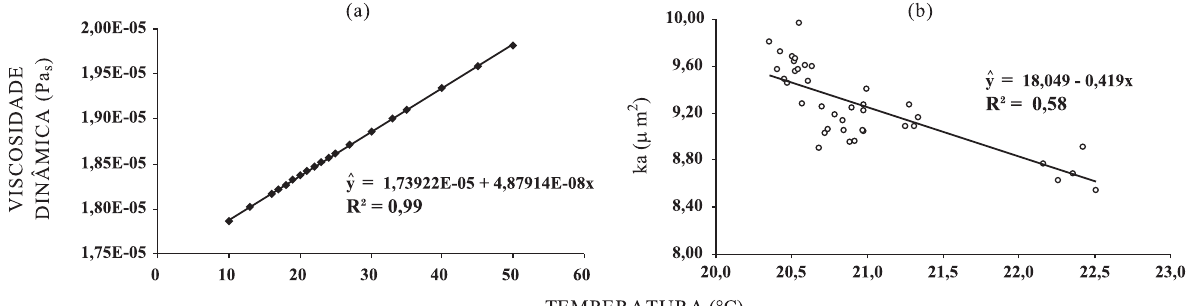
Figura 6. Regressão linear da viscosidade dinâmica do ar (a) e da permeabilidade intrínseca do solo ao ar (b) em função da temperatura ambiente. Os pares de dados apresentados em A foram obtidos no sítio